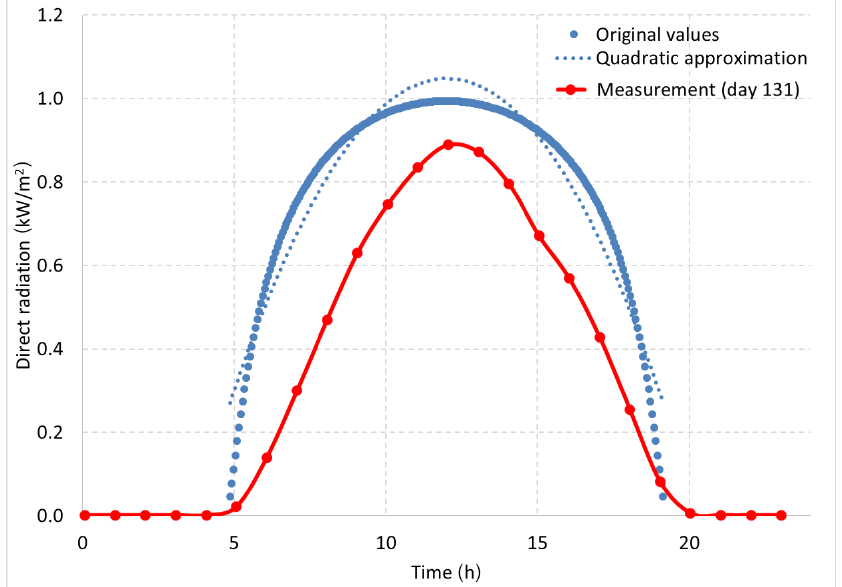
Figure 2. Original waveform of insolation and its quadratic